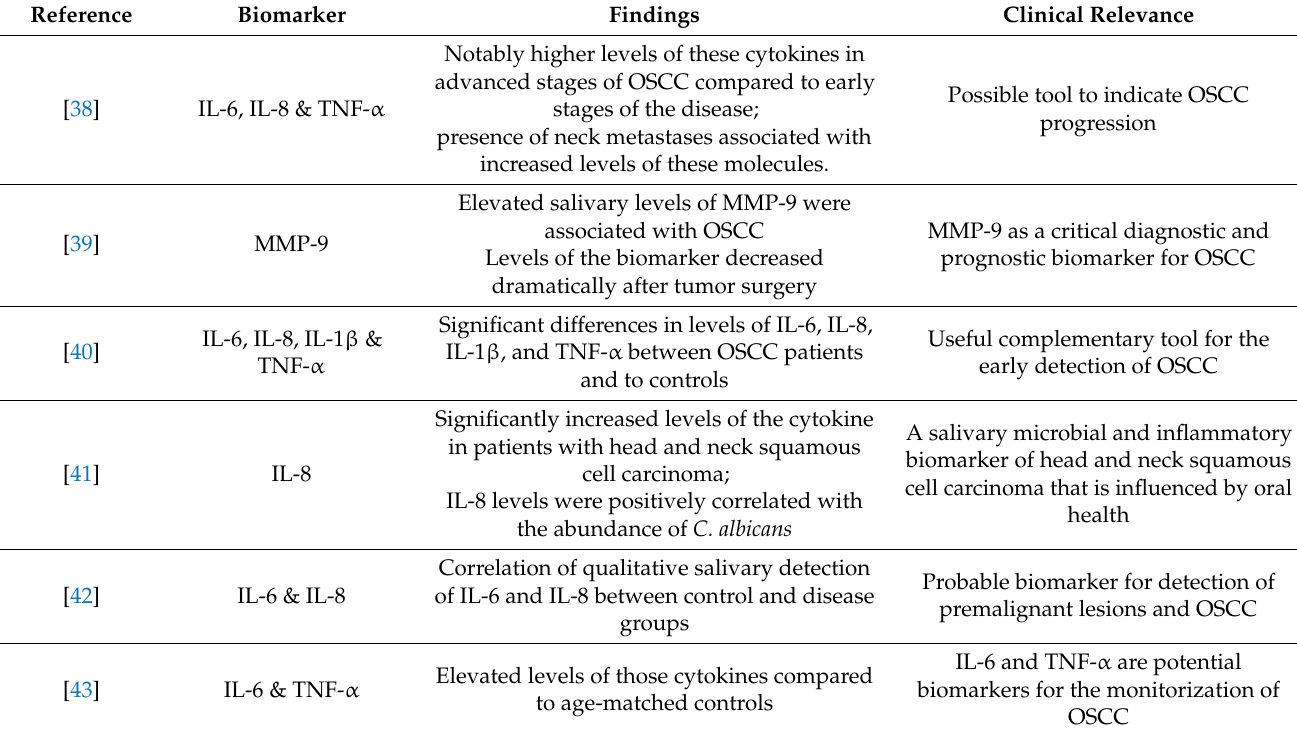
Table 2. Salivary biomarkers related to diagnosis and prognosis of oral squamous cell cancer.